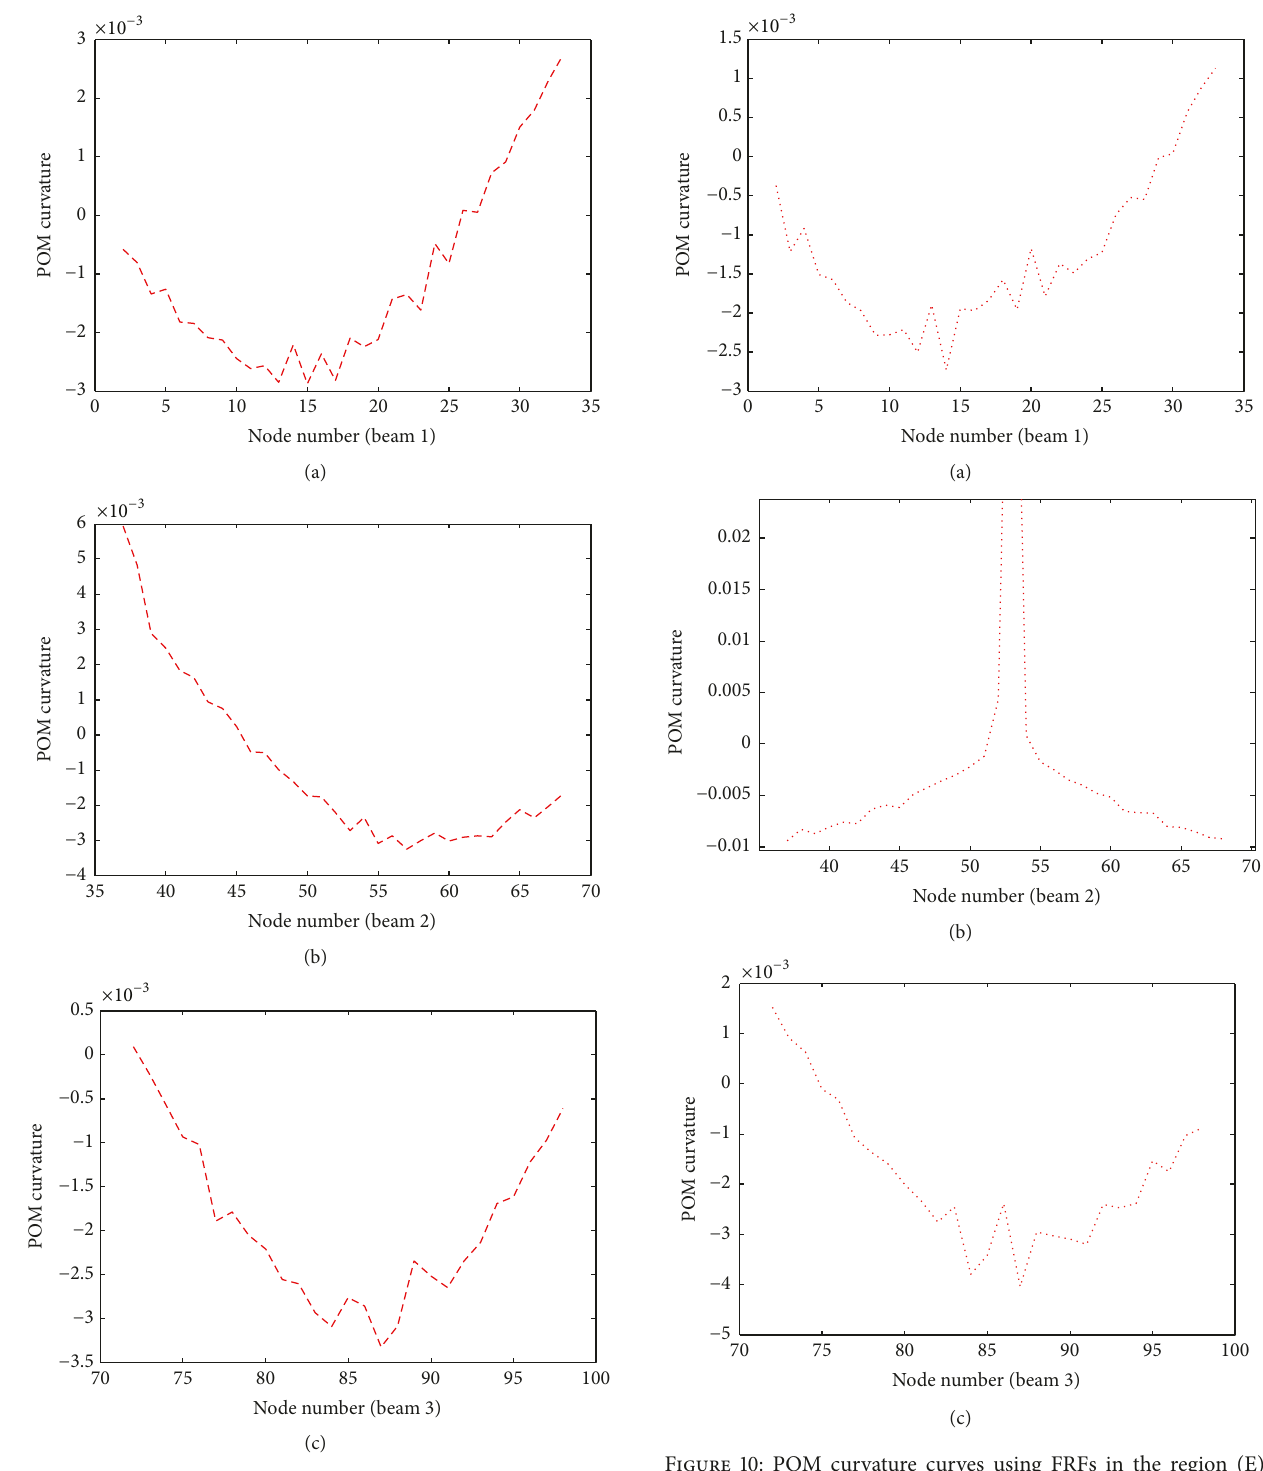
POM curve takes the absolute curve as shown in Figure 8(a).